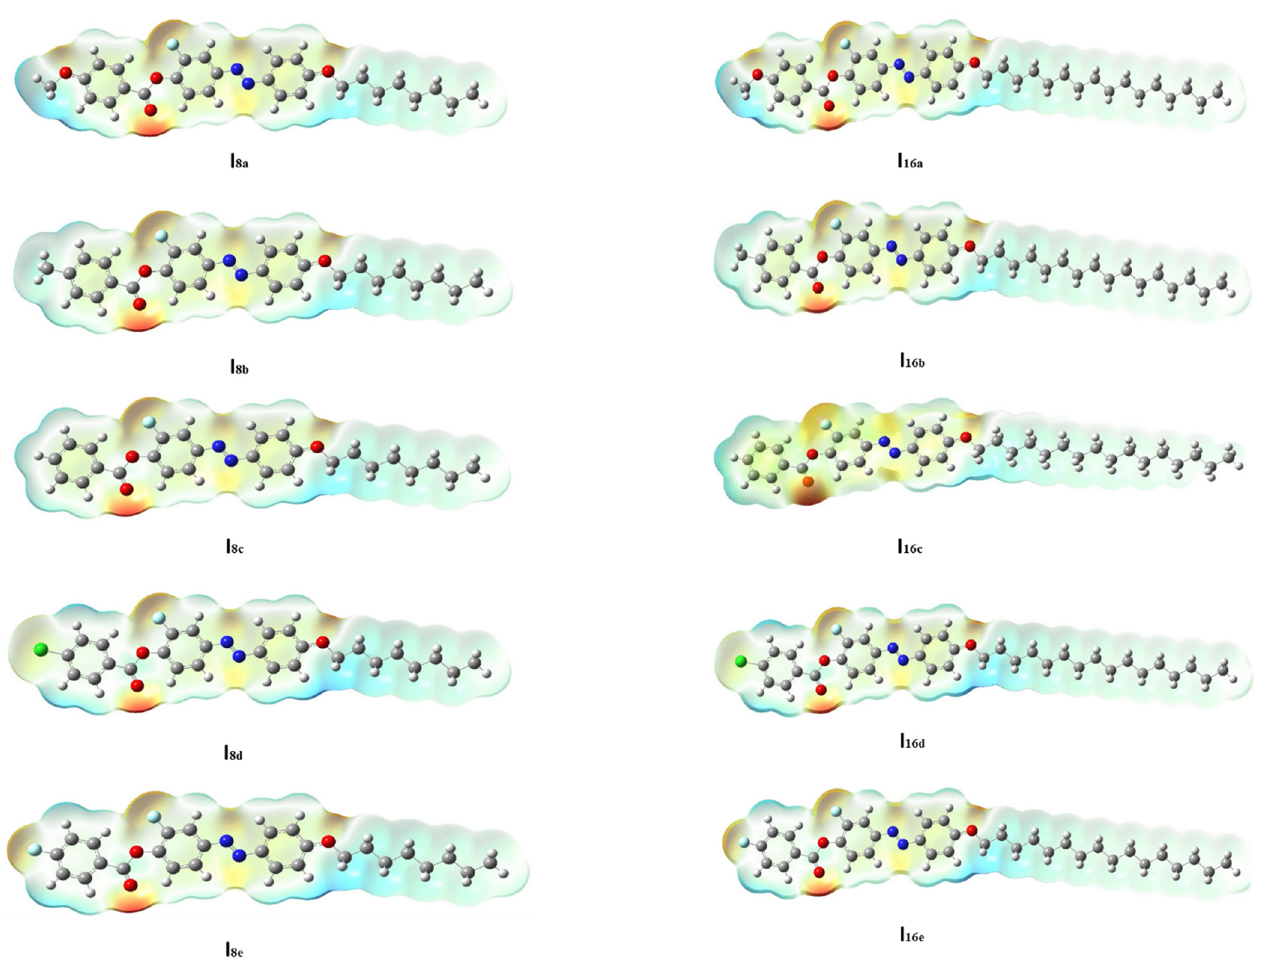
Figure 6. MEP of series, In x .